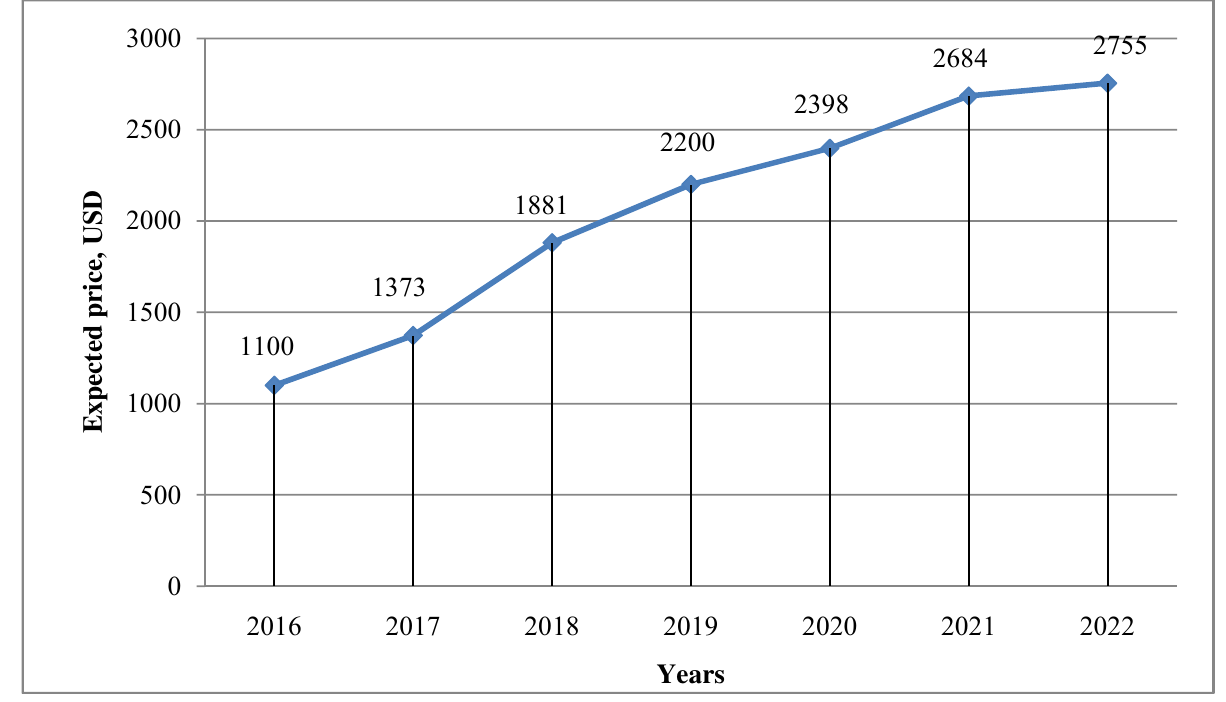
Fig. 2. Expected price of 1 hectare of agricultural land after cancelling the moratorium * Note: * Forecast IMF group Ukraine